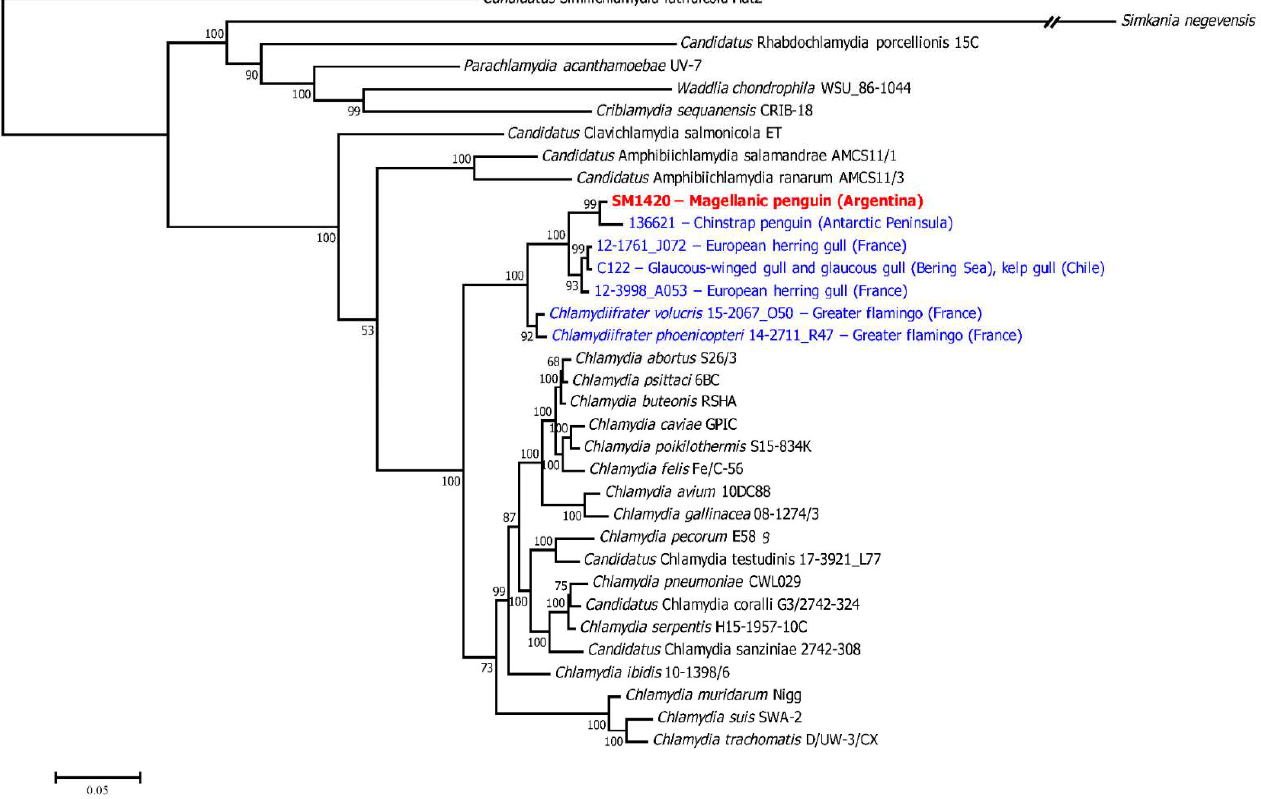
Figure 1. Bayesian phylogenetic hypothesis of the relationship between Chlamydiales spp. based on the 16S–23S rRNA region. Branch lengths are drawn proportionally to the extent of changes (scale bar is shown). Values adjacent to nodes represent posterior probabilities. The organism detected in this study is highlighted in red, and other Chalmydiaceae -like strains detected in aquatic birds are shown in blue.